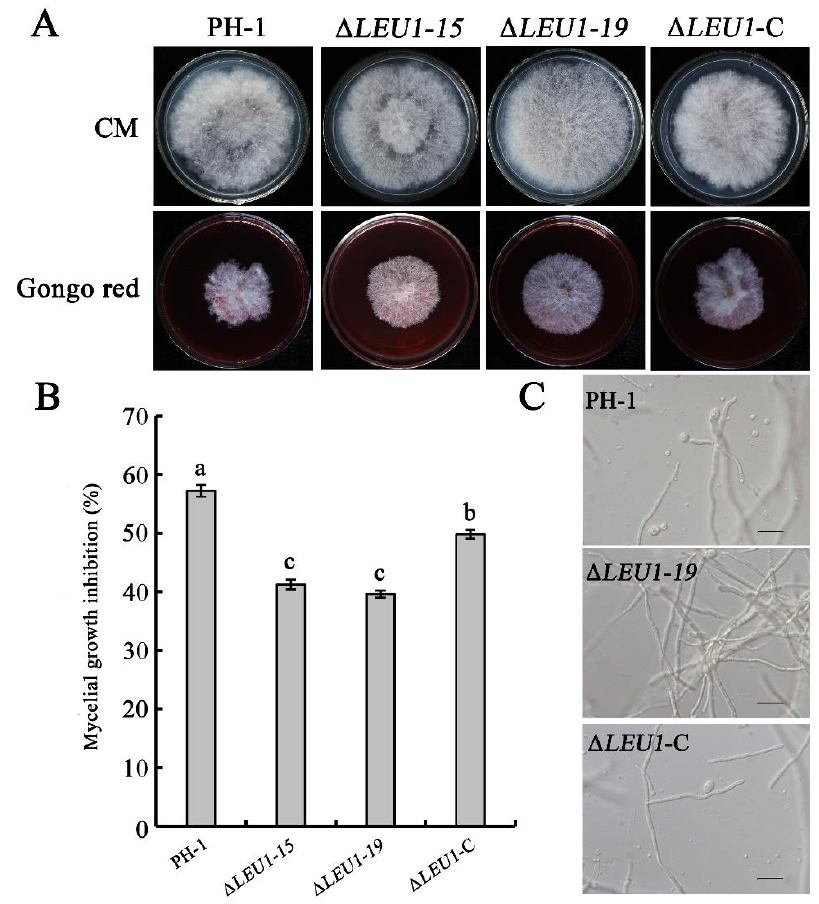
Figure 7. Role of FgLEU1 in resistance to cell wall-damaging agents and cell wall-degrading enzymes. ( A ) Comparison of PH-1, ∆ LEU1 , and ∆ LEU1 -C after 4 days of incubation at 25 ◦ C on CM plates with or without 300 mg/mL Congo Red (CR). The plates were photographed at 4 days post cultivation. ( B ) Mean rates of mycelial growth inhibition by CR on PH-1, ∆ LEU1 , or ∆ LEU1 -C strains at 4 days post cultivation. Different letters on the bars for each treatment indicate significant differences at p < 0.05 by Duncan’s multiple range test. Bar = 20 µ m. Bars denote standard errors from three experiments. Values on bars followed by the same letter for each treatment indicate absence of a significant difference at p < 0.05. ( C ) After treatment with lysozyme, driselase, and snailase for 4 h at 30 ◦ C, the mycelia of PH-1 and ∆ LEU1 -C mutants were well digested and numerous protoplasts were released, but this was not observed for ∆ LEU1